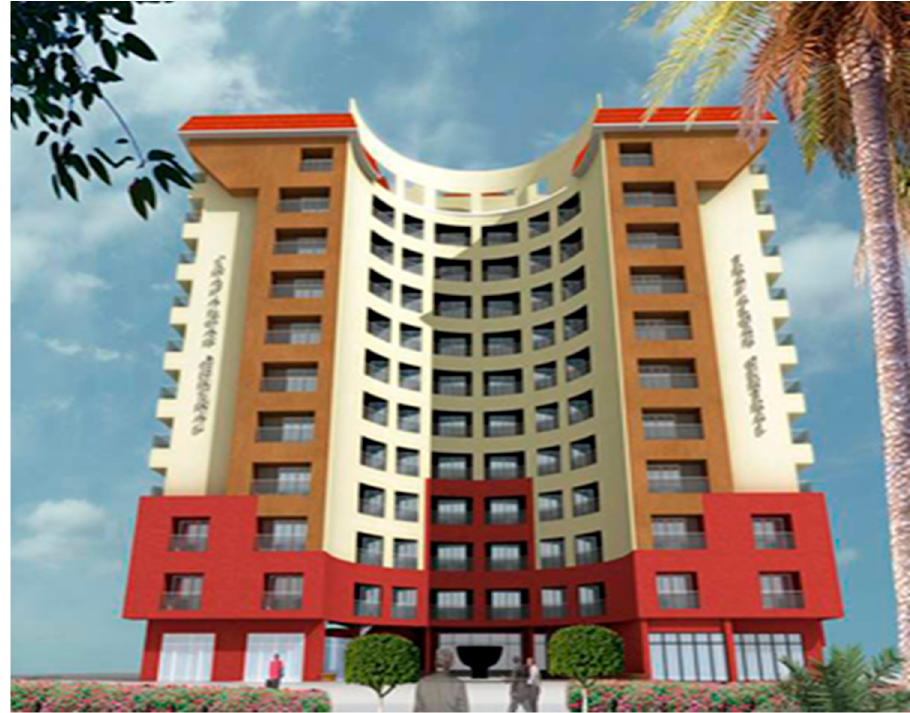
Figure 4. Trafalgar Central (TC), International City, Dubai, UAE.